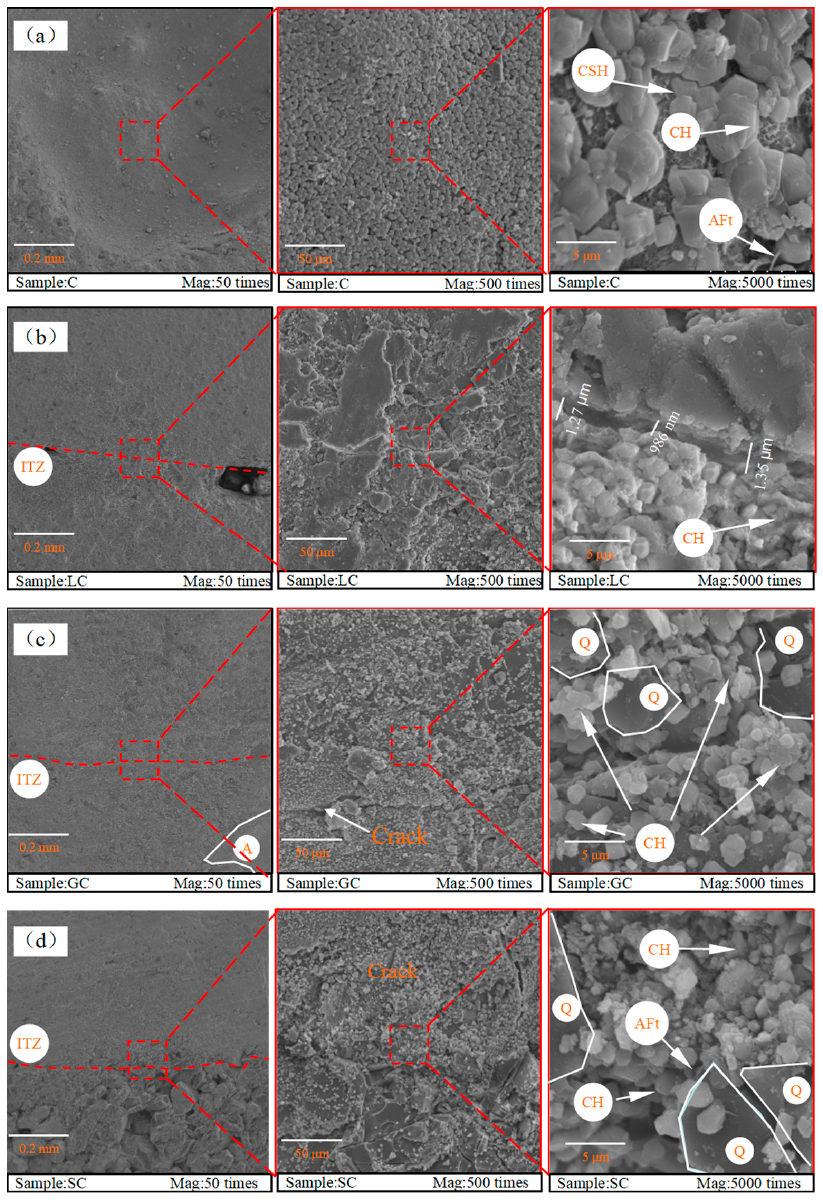
Figure 7. SEM images of ITZ microstructure at different magnifications: ( a ) C; ( b ) LC; ( c ) GC; ( d ) SC; “A”—aggregate, “Q”—quart particles.